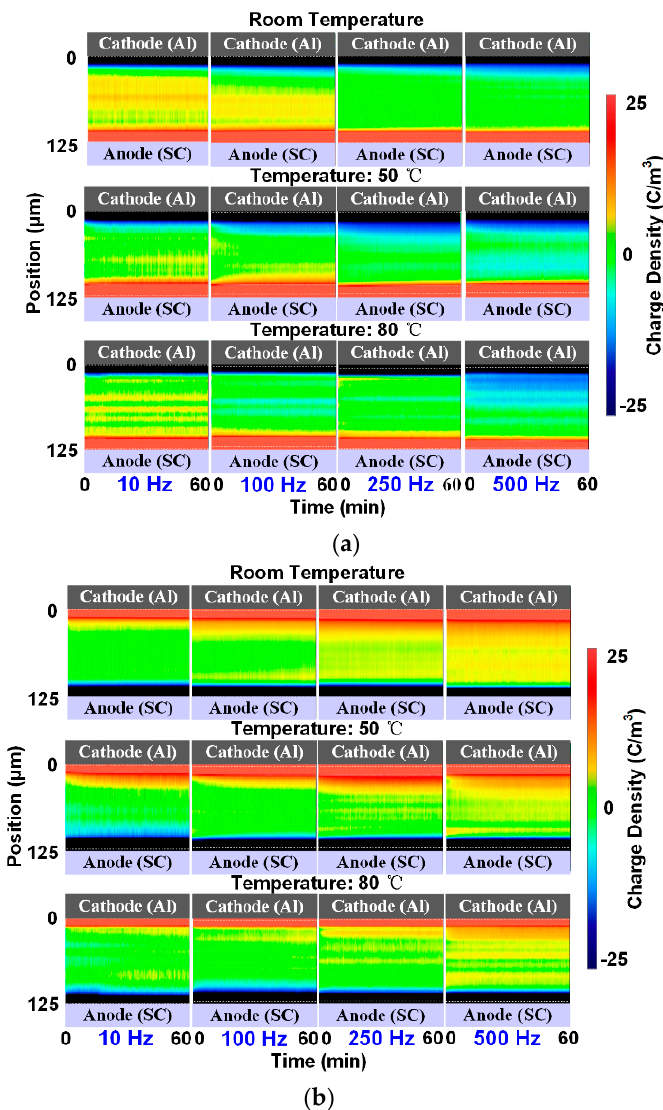
Figure 7. Charge results under rectangular wave voltages at different temperatures: ( a ) positive voltages, ( b ) negative voltages.